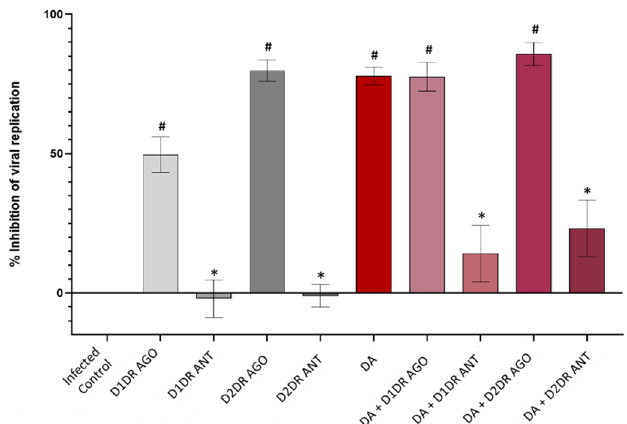
Figure 2. Effects of the D1 and D2 dopamine receptor agonists and antagonists in SARS-CoV-2 replication. D1DR and D2DR agonists (10 μ M) reduce SARS-CoV-2 replication at 48 h post-infection, recapitulating the antiviral effect of DA (50 μ M), which is instead reversed by D1DR and D2DR antagonists (10 μ M). In detail, while the antiviral effect of the D1DR agonist alone is modest, reaching 50% of viral replication inhibition, the D2DR agonist either alone or in combination with DA, produces a robust antiviral effect (>80% inhibition of detectable viral RNA) which recapitulates and slightly surpasses that produced by DA alone. On the other hand, administration of either D1DR or D2DR antagonists alone favors SARS-CoV-2 replication, meanwhile occluding the antiviral effects of DA in the co-administration protocol. Values are expressed as percent (%) inhibition of viral replication, calculated as “1–SARS-CoV-2 N gene copy number of SARS-CoV-2-infected treated cells/SARS-CoV-2 N gene copy number of SARS-CoV-2-infected Control (untreated) cells”, with SARS-CoV-2 Infected Control corresponding to 0% Inhibition of viral replication. The absolute viral copy number of the SARS-CoV-2 N gene from cell supernatants was quantified through a single-step, real-time, RT-qPCR by referring to a standard curve from RT-qPCR Ct values (IDT, Coralville, IA, USA). Results are presented as mean ± SEM from at least n = 3 independent experiments, each performed in